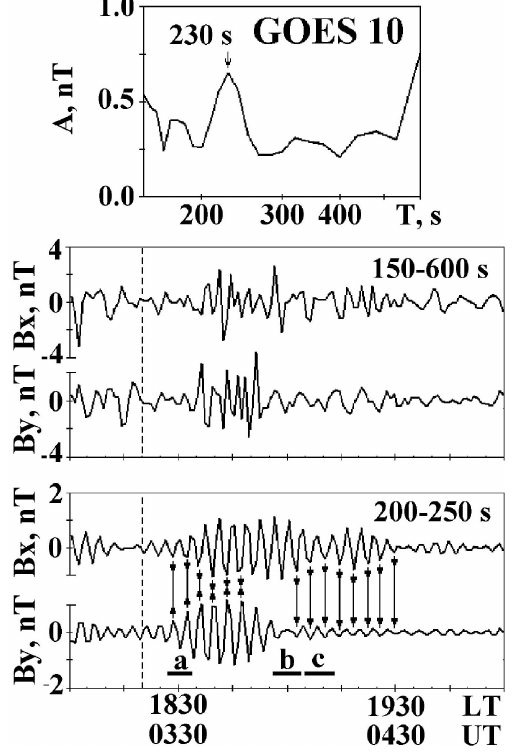
Fig. 2. Features of the 17 September 2000 event in an xy-plane as seen by GOES 10. From the top to the bottom: the spectrum of polarization ellipse major semi-axis, the B x and B y time variations filtered in the entire Pc5 range and in the range near the spectral peak. The substorm onset is marked by a dotted line. Some of the B x (t) and B y (t) maxima/minima are marked by arrows pointing